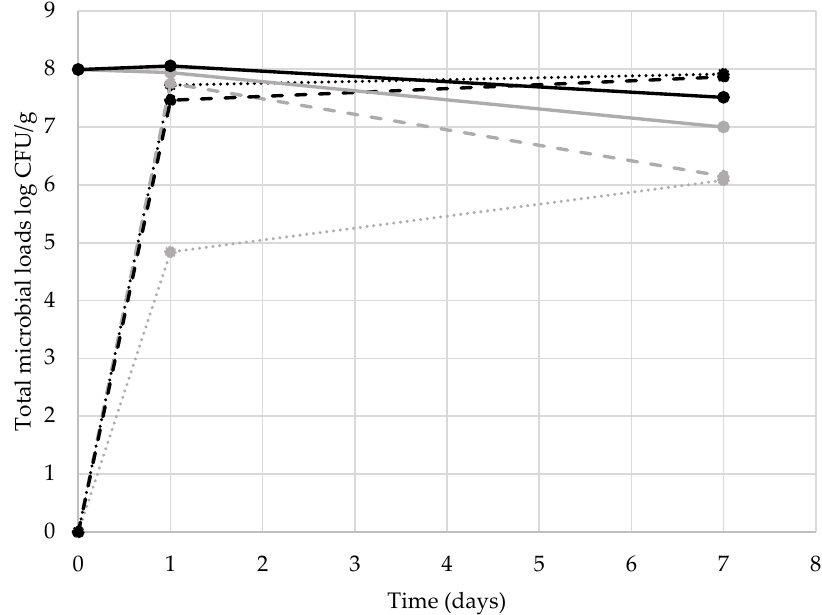
Figure 3. Total microbial loads in the substrates (with and without larvae) and larvae. Listeria monocytogenes inocula of 2 log CFU/g and 6 log CFU/g, respectively, in grey and black. The dotted lines represent the counts in the substrate without the larvae, the dashed lines represent the counts in the substrate with the larvae, and the full lines represent the counts of the larvae. For L. monocytogenes, statistically signi fi cant di ff erences were detected between the loads of the inocula both on the substrates and on the larvae, as well as between the tested days. L. monocytogenes load decreased in the substrates without larvae with a log CFU/g at T1 of 5.76 and 1.88, respectively, for the inocula of 6 and 2 log CFU/g. Similarly, the loads decreased in the substrate with the larvae reaching 5.14 and 1.88 log CFU/g, respec- tively. After seven days, the L. monocytogenes load was under the detection limit for the substrates spoiled with 2 log CFU/g (with and without larvae), while the substrate inocu- lated with the higher concentration of the bacteria reached loads of 4.26 when the larvae were absent and 2.83 when the insects were fed the substrate. At T1, the larvae showed a load of L. monocytogenes of 1.65 and 3.77 log CFU/g, respectively, for the inoculated sub- strate of 2 and 6 log CFU/g. At both inocula levels, the larvae did not carry the bacteria at T7. These results are in contrast with those of Belleggia et al. [17] and Mancini et al. [16] in mealworms, who highlighted the persistence of L. innocua (at 1, 5, and 7 log CFU/g) and L. monocytogenes (at 8 log CFU/g) for 7 days. Therefore, some di ff erences in the two insect species must produce di ff erent responses to the presence of the bacteria species. The level of contamination and the trial length could also have a ff ected the bacterial dynamics, as also reported by Wynants et al. [26] in mealworm larvae reared in substrates spoiled with Typhimurium (LMG 18,732), and Salmonella enterica serovar Infantis (LMG 18,746). The total microbial counts at T1 of the substrate without the larvae were 4.84 and 7.72 log CFU/g for the inocula 2 and 6 log CFU/g of L. monocytogenes, respectively. The sub- strates with the larvae showed total counts of 7.75 log CFU/g (2 log inocula) and 7.46 log CFU/g (6 log inocula). At T7 the substrates showed total loads of 6.08 and 7.91 log CFU/g for the crates without the larvae and of 6.15 and 7.87 log CFU/g for the crates with the